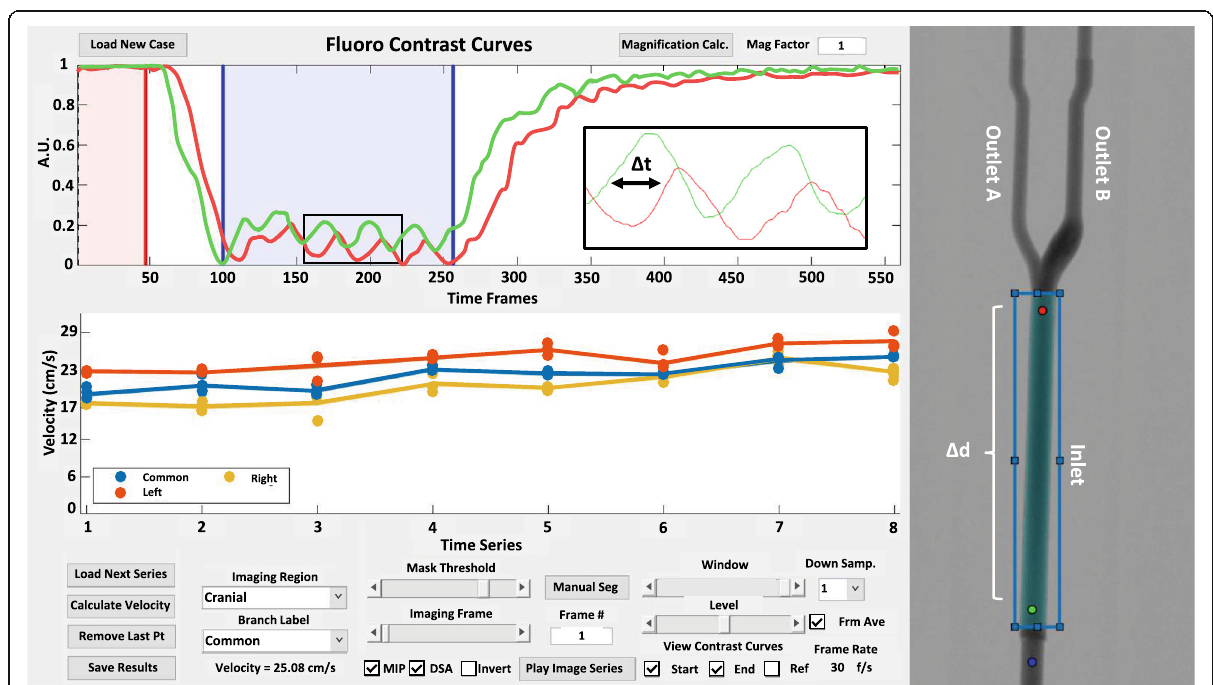
Fig. 1 qDSA calculations were completed with the custom built post processing tool in MATLAB. Vessel start and end points are selected by moving the red and green points on the acquired image. Temporal windowing is adjusted by changing the blue shaded region overlaid on the time attenuation curves. The spatial information and temporal information used for velocity calculation are derived from the Δ d and Δ t. Visualization of the acquired image series can be completed using the tool ’ s built in